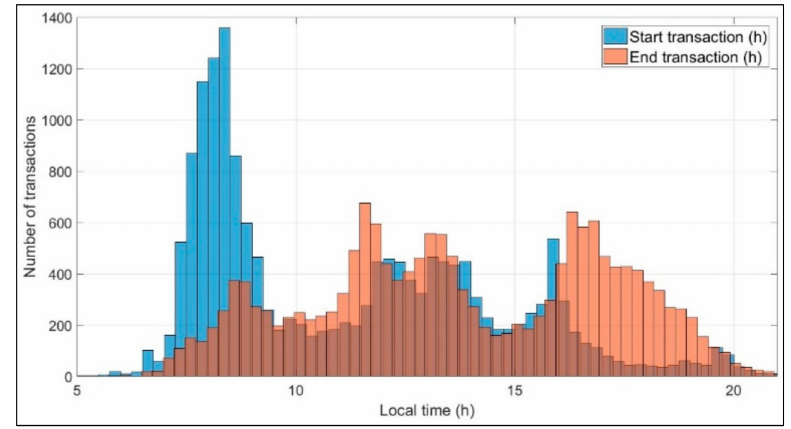
Figure 1. Histograms of start and end times of charging